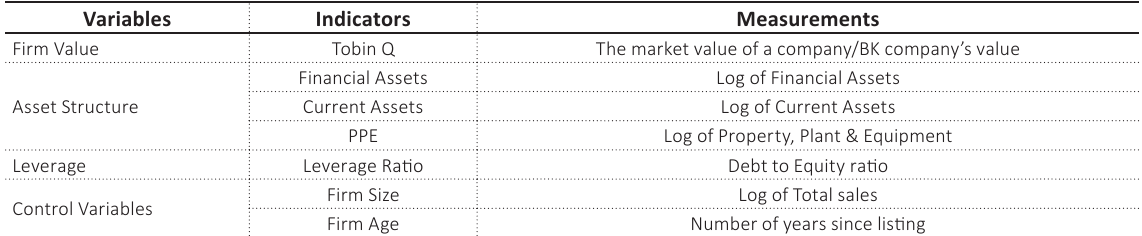
Table 1. Measurement of